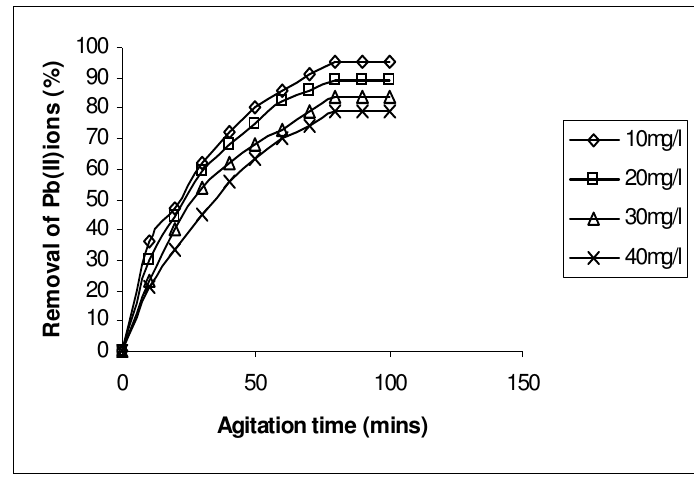
Figure 3. Effect of agitation time and initial Pb(II) ion concentration